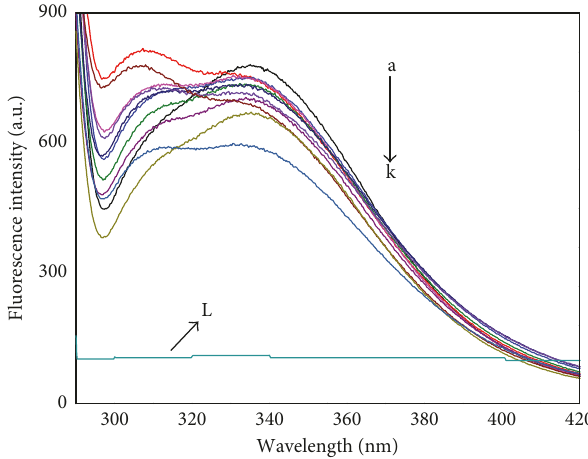
Figure 3: Fluorescence emission spectra of BSA (2 . 5 × 10 − 6 mol · L − 1 ) with varying concentrations of RSN (a to k: 0.5 to 5 . 5 × 10 − 6 mol · L − 1 ) with the addition of 0 . 5 × 10 − 6 mol · L − 1 in each step, and the curve L represents RSN only (2 . 5 × 10 − 6 mol · L − 1 ) at 297K and pH